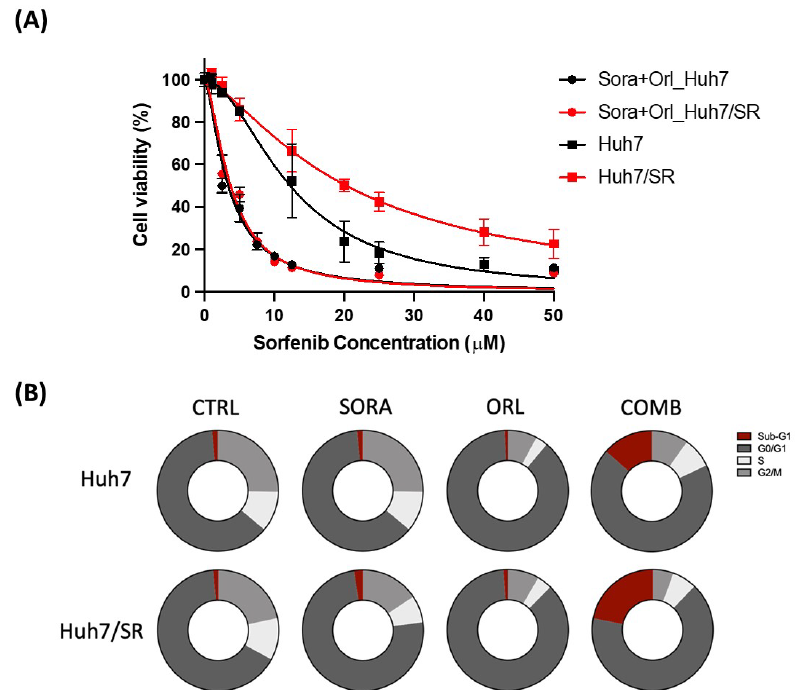
lines, although sorafenib was more effective at cell killing in Huh7/SR cells than Huh7 cells.